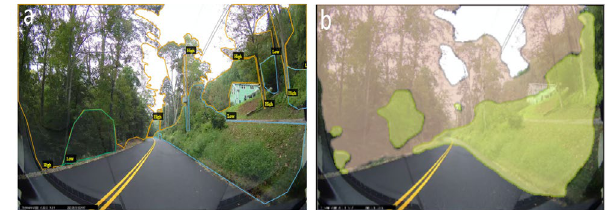
Figure 5: a) Annotated video frame b) Prediction mask for high canopy (pink color) and low canopy (light green color).